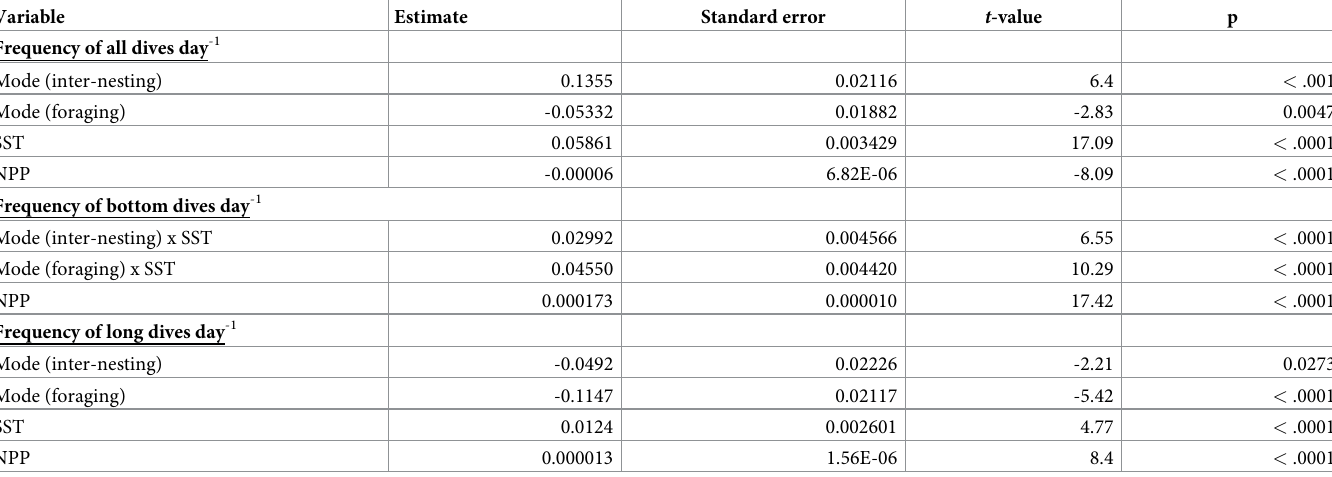
Table 1. Estimated parameters for the best models for behavioral variables.